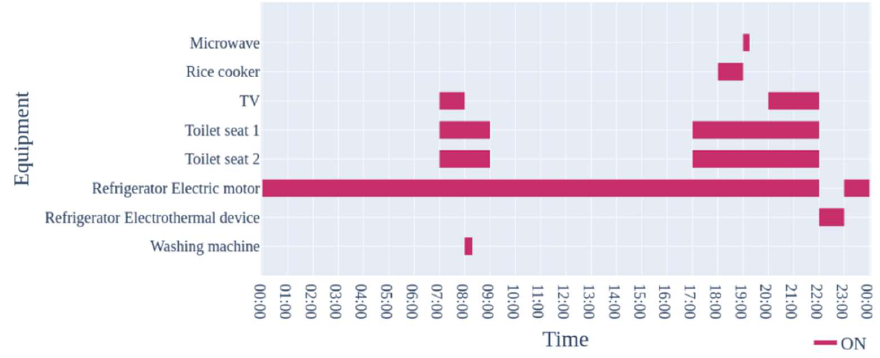
Figure 5. Appliances usage plan .